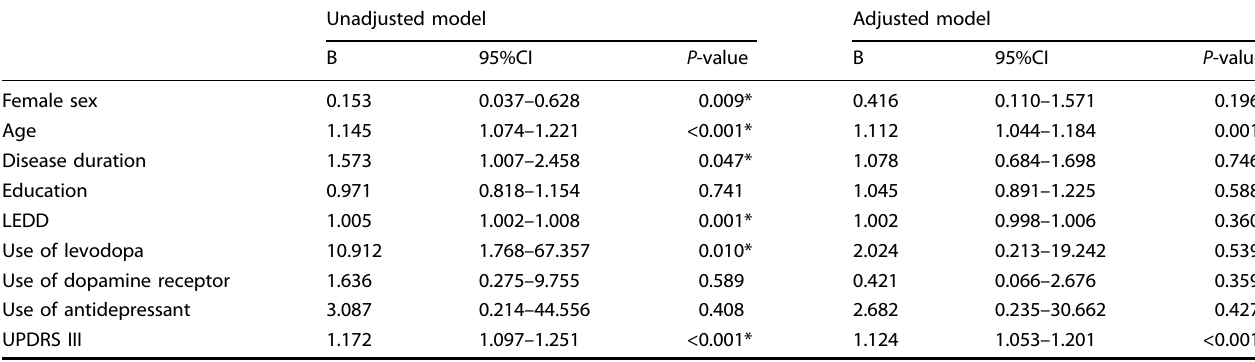
Table 2. Factors associated with the number of NMS in patients with PD.